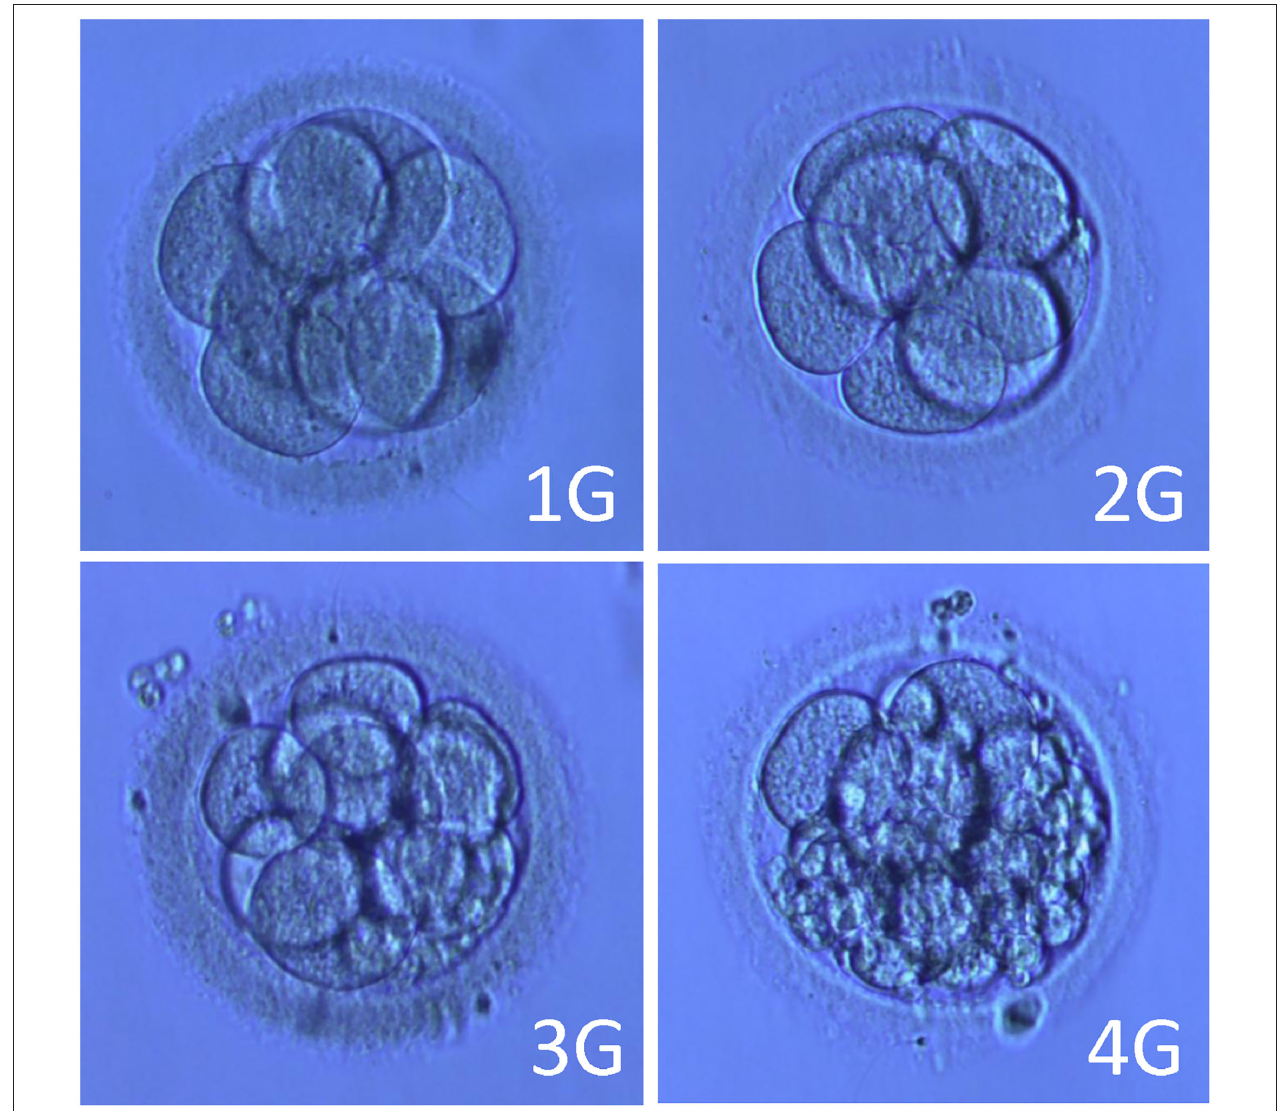
FIGURE 2 | Pictures of embryos of different grades. Note: 1G (Grade 1 embryo): blastomere equality, regular morphology, bright, no fragment. 2G (Grade 2 embryo): blastomere unequal in size and/or fragmentation < 10%. 3G (Grade 3 embryo): 10–50% fragments. 4G (Grade 4 embryo): fragmentation > 50%.